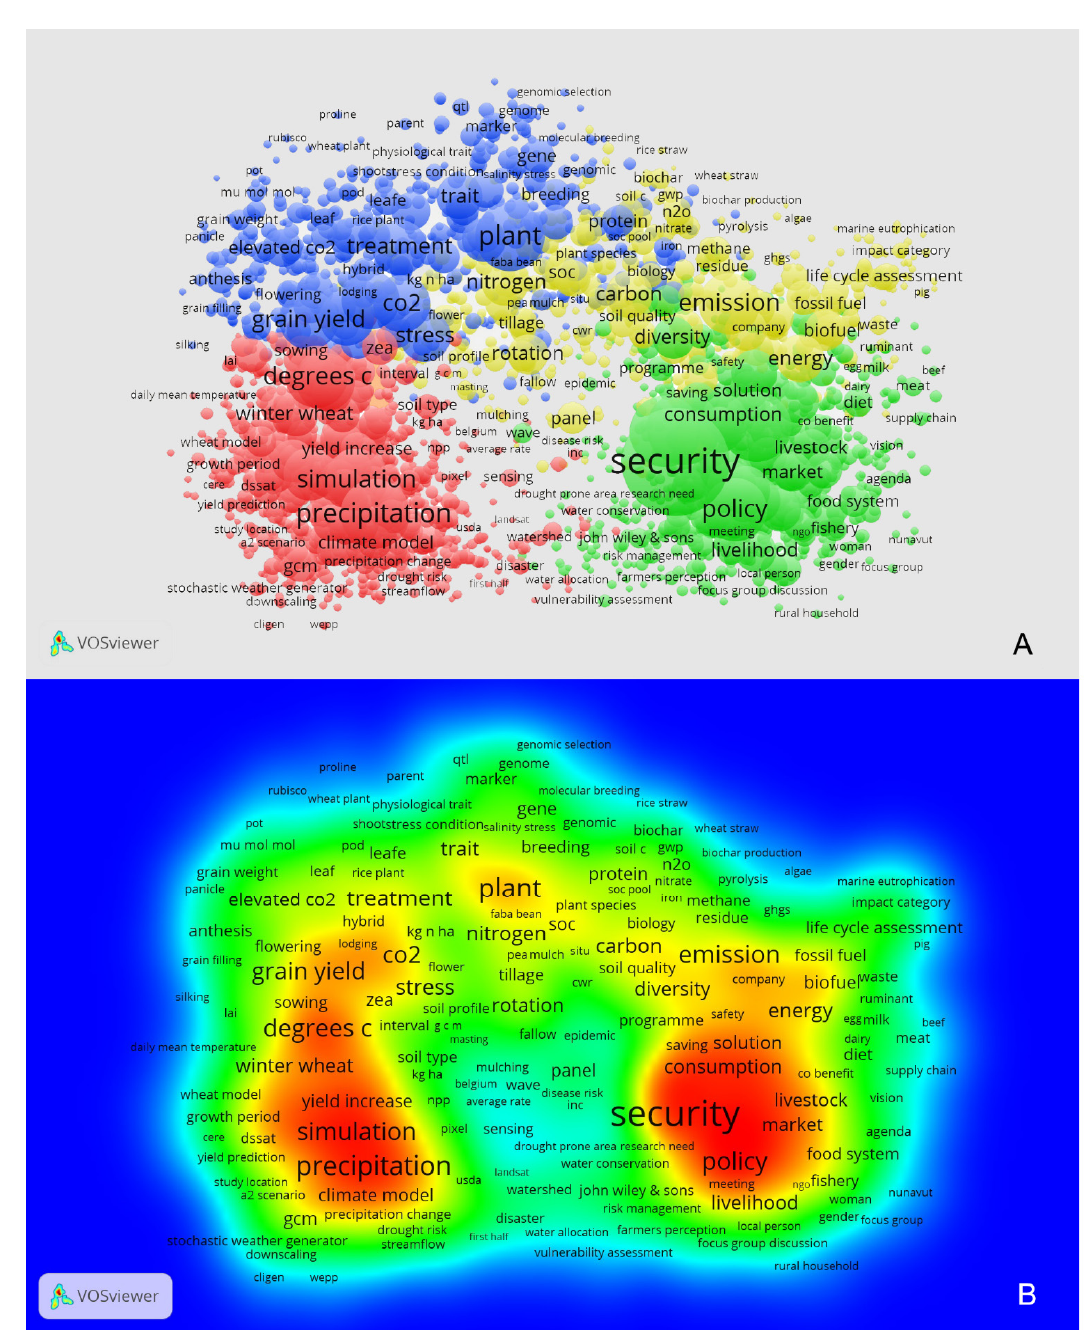
Figure 3. The keywords cluster analysis ( A ) and research hot-spot analysis ( B ) with the VosViewer for all scientific references of climate changes in grain productions.